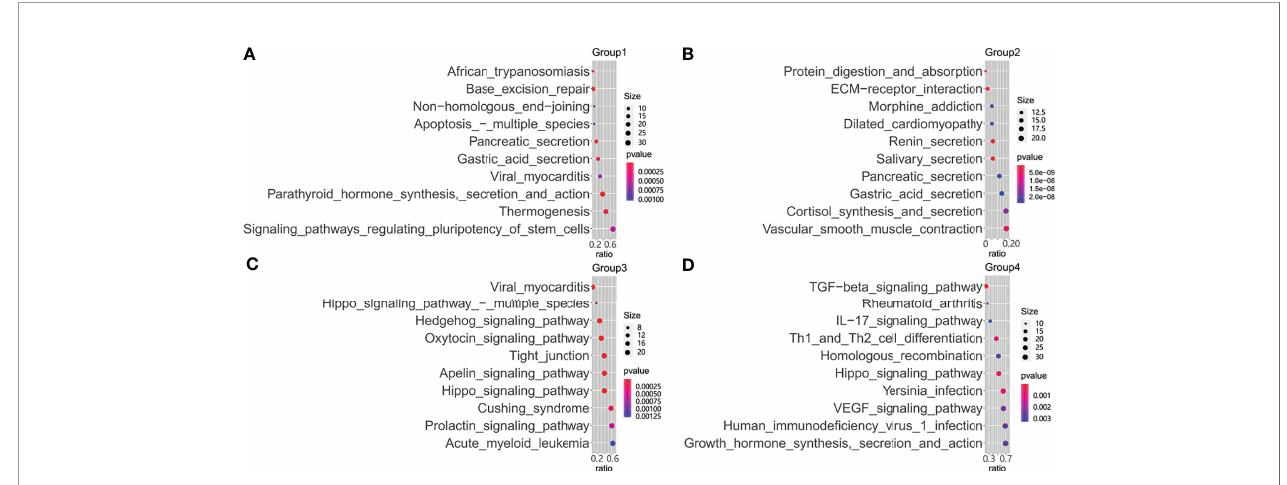
FIGURE 4 | Functional enrichment of mutational genes. Enriched Kyoto Encyclopedia of Genes and Genomes (KEGG) pathways for mutated genes are plotted against the odds ratio in patient groups 1 (A) , group 2 (B) , group 3 (C) , and group 4 (D)